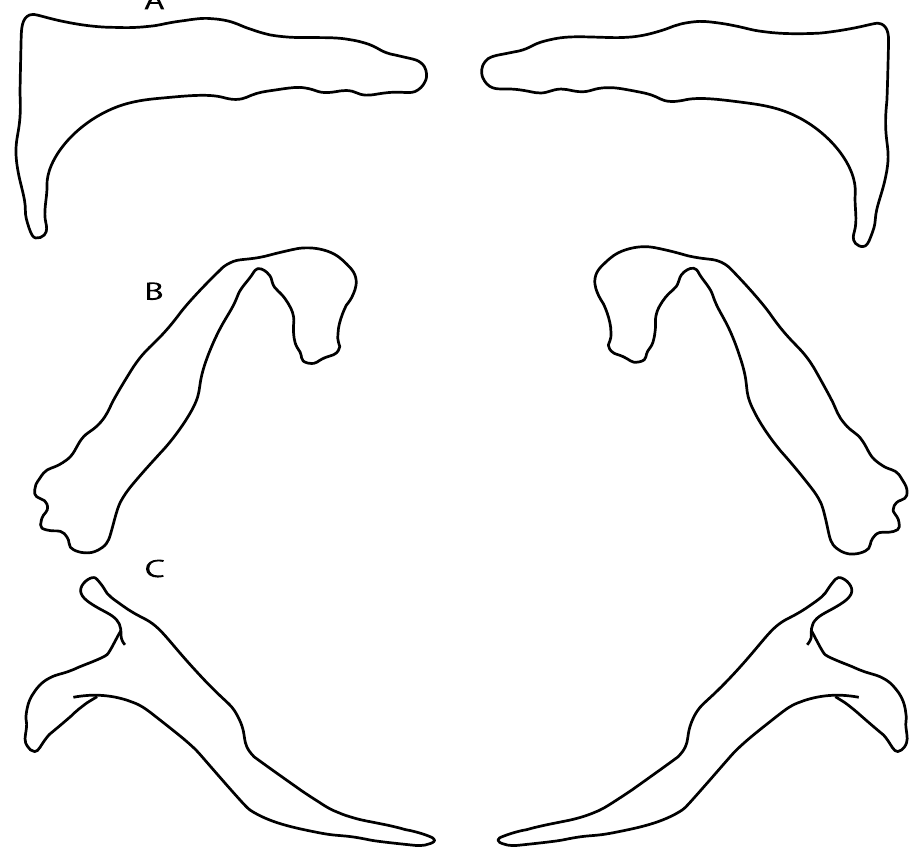
Figure 35. Interpretative drawings of the dorsal portion of the scapula. State (0): ( A ) Zapteryx exasperata (CNPE–IBUNAM 20528). State (1): ( B ) Narcine bancroftii (CAS 18246). State (2): ( C ) Pseudobatos percellens (UERJ 1240).